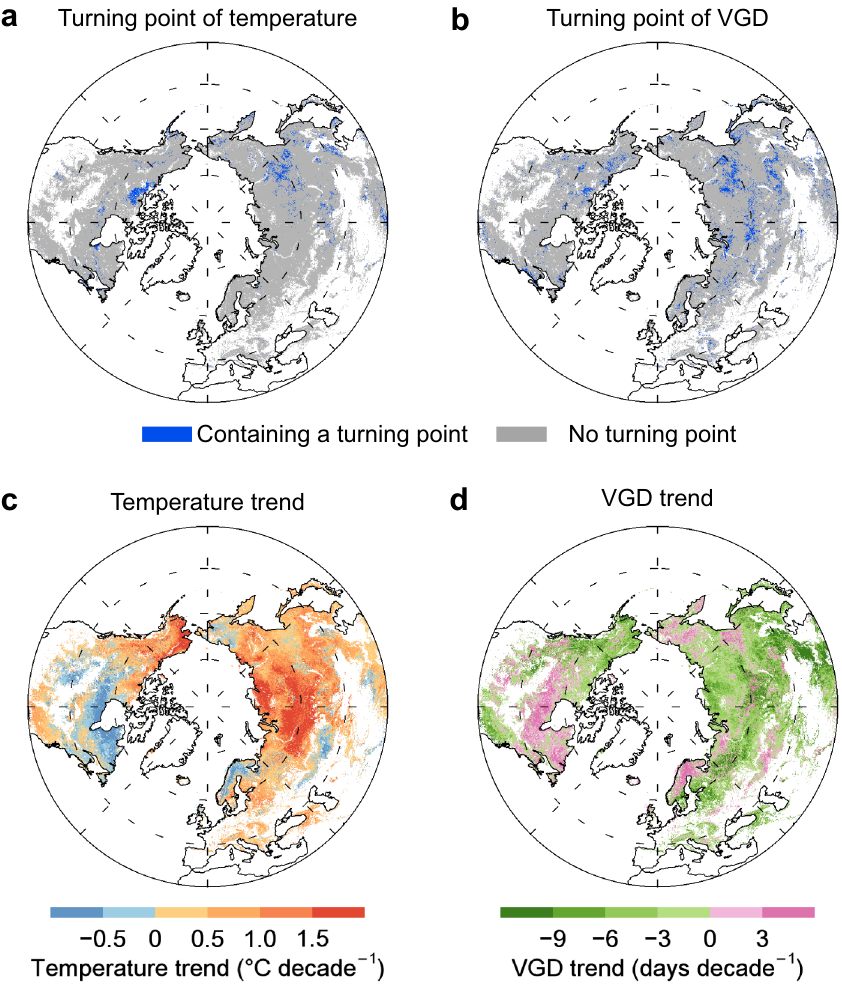
Fig. 2 Temporal trends in mean temperature in the period preceding VGD (pre-VGD temperature) and onset date of vegetation green-up (VGD). Blue pixels indicate turning points determined by the corrected Akaike information criterion (see Supplementary Methods) in a pre- VGD temperature and b VGD trends during 2000 – 2021. c , d Linear regression modeling of trends in pre-VGD temperature and VGD over the period 2000 – 2021. VGD is determined by the threshold-based method as the fi rst date when NDVI increases by 20% of the annual amplitude in the ascending period of the annual NDVI